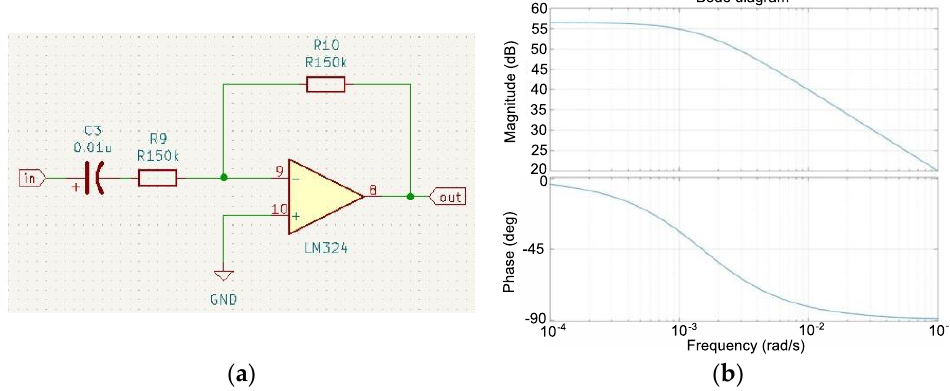
Figure 5. Connection diagram of the second LM324 operational amplifier circuit in the configuration of the first-order high-pass filter ( a ), frequency-phase characteristic of the high-pass filter ( b ). After processing the signal with the high-pass filter, the negative amplitude was removed because the microcontroller used at a later stage did not have symmetrical inputs ( ± 12 V), but analog inputs had an acceptable measuring range of 0–5 V. The removal of this amplitude generated data with extremely high dynamics of change, which significantly hindered digital processing. The solution reflected the negative amplitudes relative to the equilibrium position and then smoothened them. Such a procedure yields a signal with significantly reduced dynamics which is, at the same time, locally stable, enabling its unambiguous interpretation by means of a microcontroller. For this purpose, a precise full-wave rectifier was developed, the design of which was based on two operational amplifiers (Figure 6a).